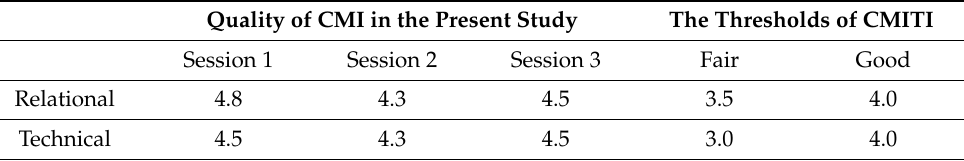
Table 3. Descriptive results of CMI coding (four cases randomly selected from the total